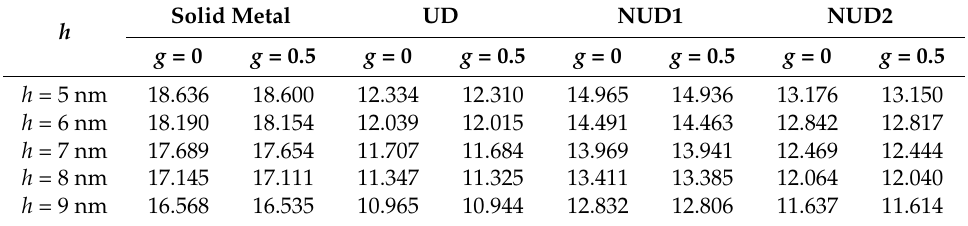
Table 4. The non-dimensional critical buckling loads with different thicknesses, small scale parameters and porosity distributions of square nanoplate ( l a = l b = 50 nm, m = n = 1, ζ = 1, λ = 0.5).